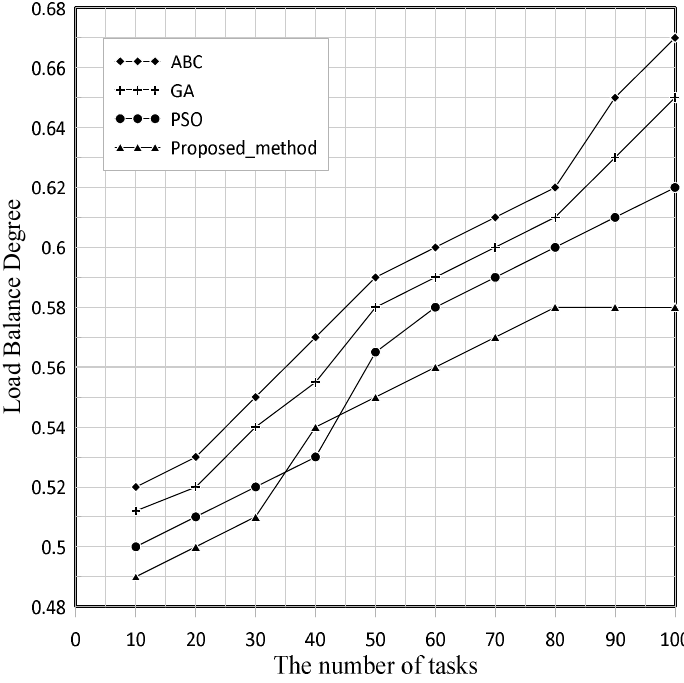
Figure 11. Comparison of the results of the load balance degree .